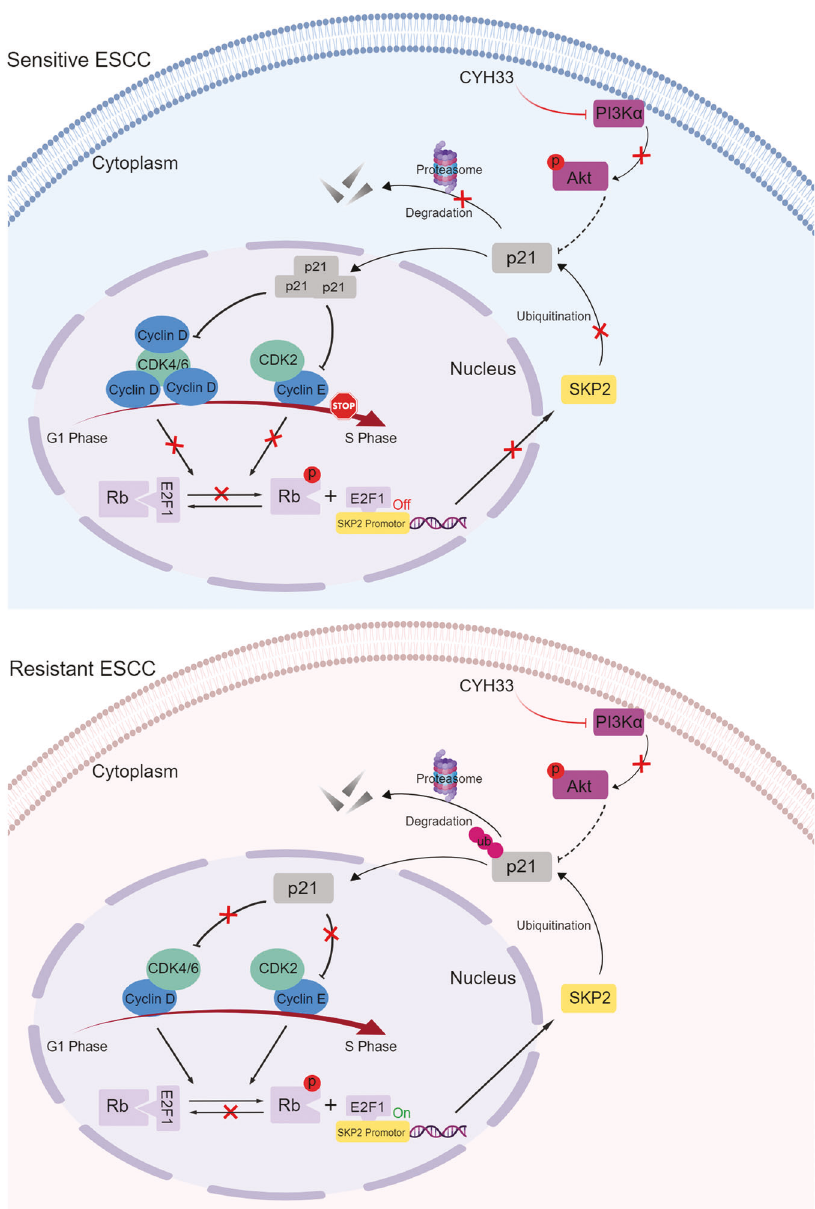
Fig. 7 CYH33 arrested sensitive ESCC cells at G1 phase via the p21-Rb-E2F1-SKP2 positive feedback loop. A proposed scheme representing that the intact regulation on the G1/S transition via the p21-Rb-E2F1-SKP2 positive feedback loop determines the differential sensitivity to CYH33 in